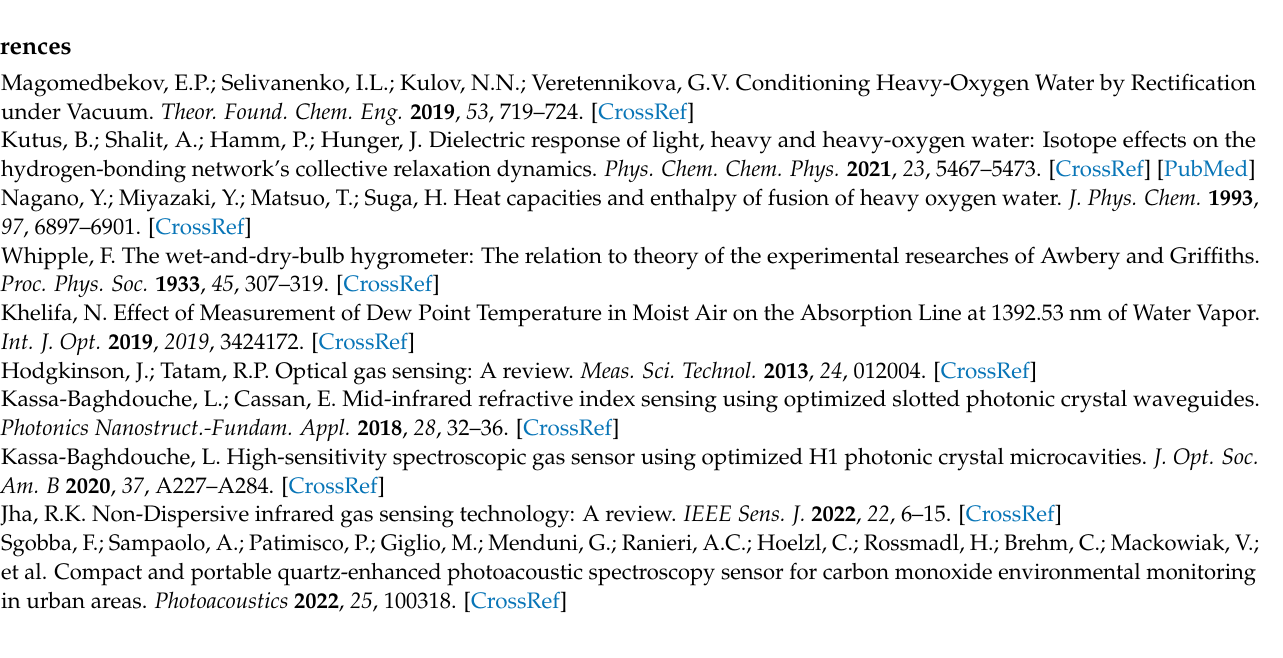
Figure 9. Relative humidity measured in WMS-TDLAS.